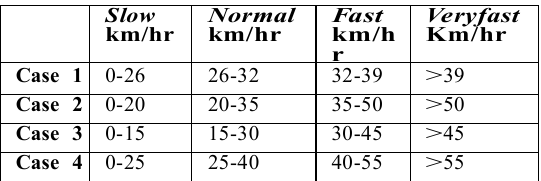
Table 9 . Speed Ranges of Multiple Cases for Different Classifications.